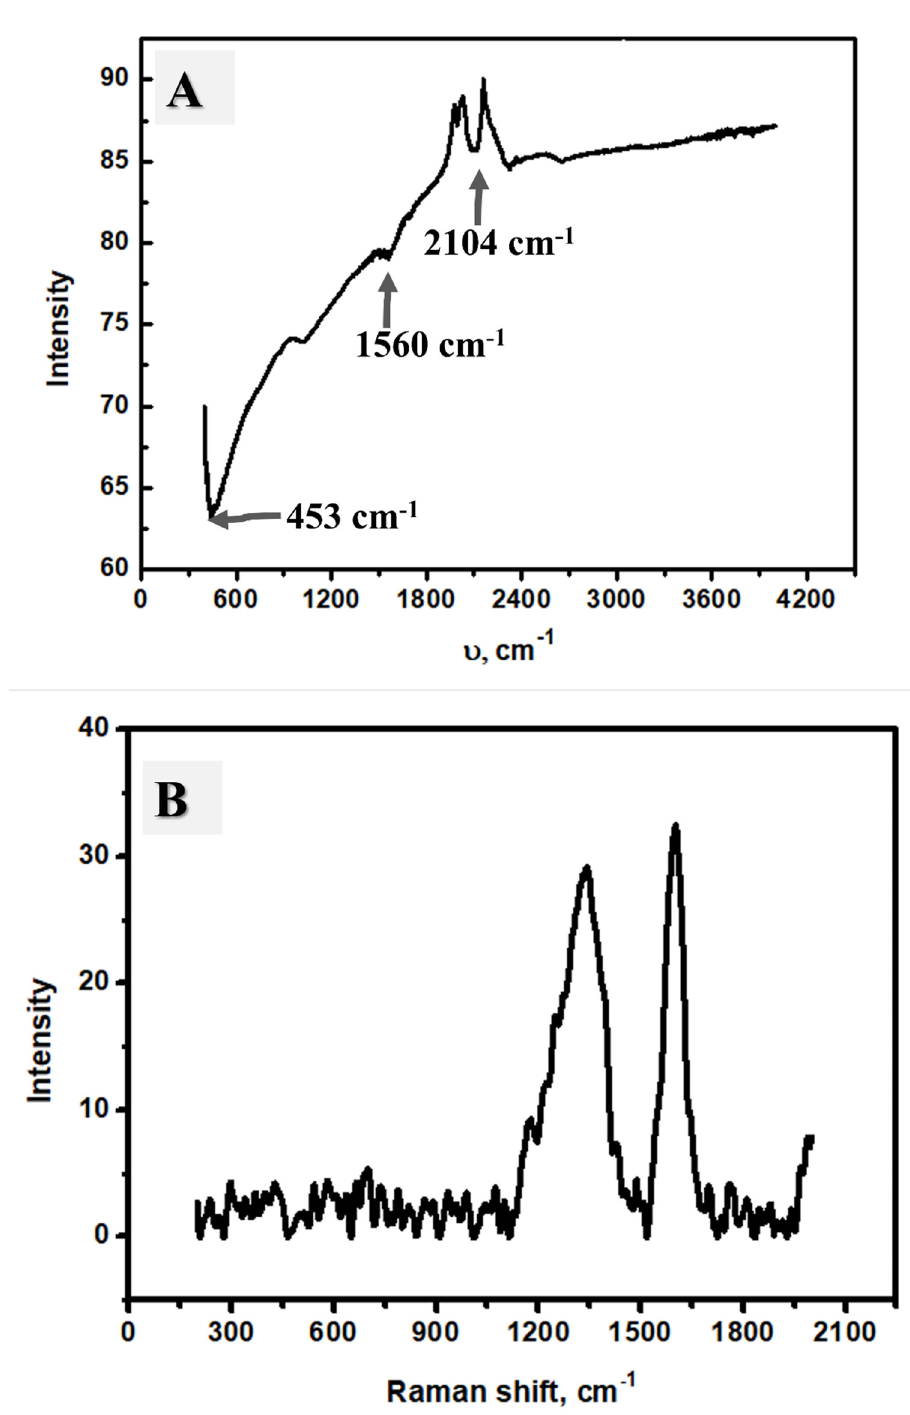
Figure 2. FT-IR; ( A ), and Raman spectroscopy; ( B ) of the prepared Fe(0)@AC. The Raman spectral was studied at a range of 200–2100 cm − 1 in order to identify the synthesized Fe(0)@AC. Two sharp peaks were seen in the Raman spectra of Fe(0)@AC material (Figure 2B) at 1601.80 cm − 1 and 1341.05 cm − 1 . The first peak could be due to the G-peak, which is the graphite scattering peak of the graphite carbon structure. Another sharp peak could be attributed to the D-peak, which is interpreted by lattice defects or disordered arrangement [35]. In conclusion, it can be understood that the AC in the pre- pared Fe(0)@AC has a graphitic character after modification by zero-valent iron [36].